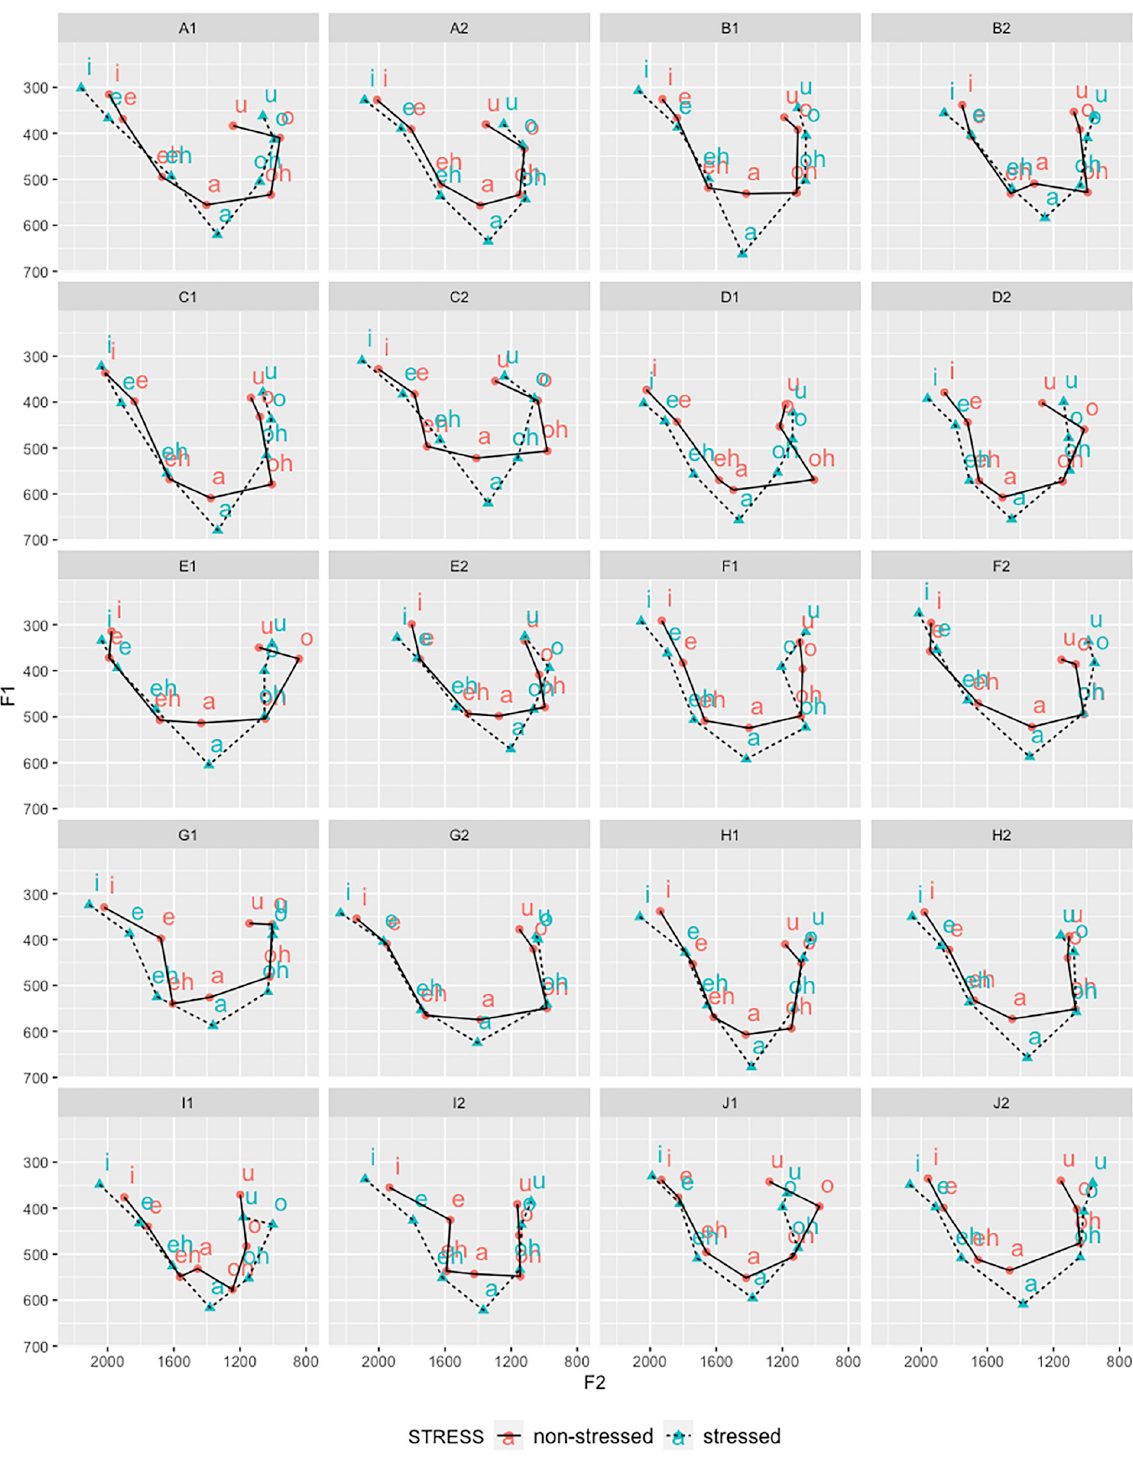
Fig 3. Effects of lexical stress in the two-dimensional vocalic space intra- and inter-speakers.